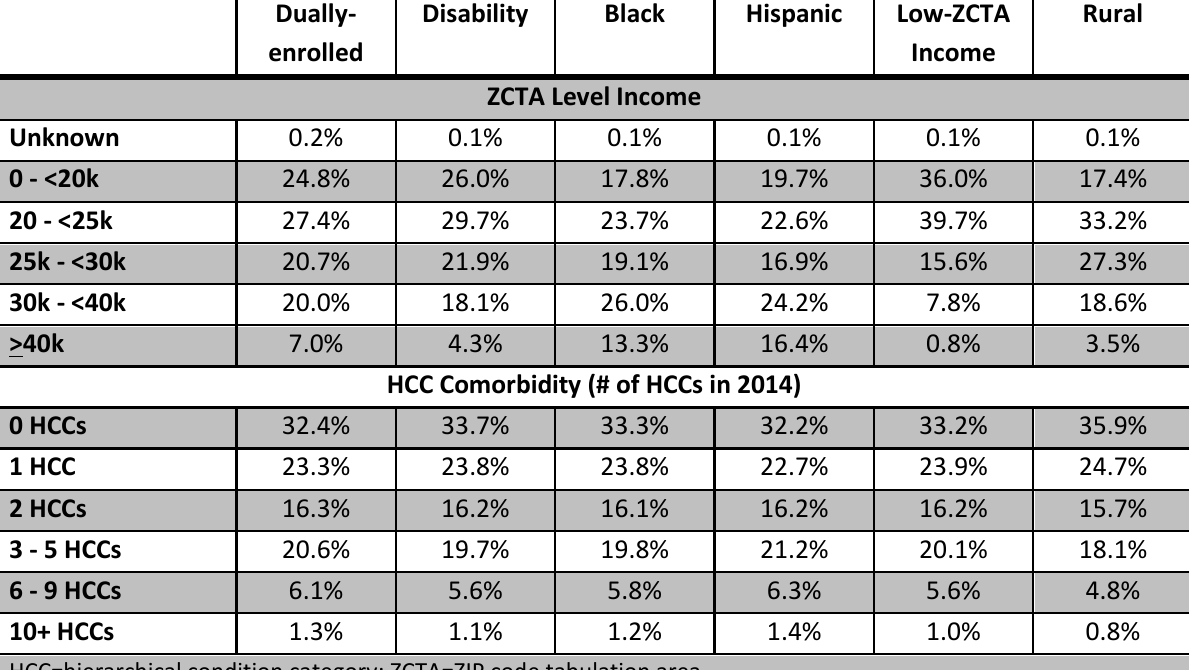
Table 9.1b continued: Patient Characteristics, Beneficiary Social Risk Groups within ACOs